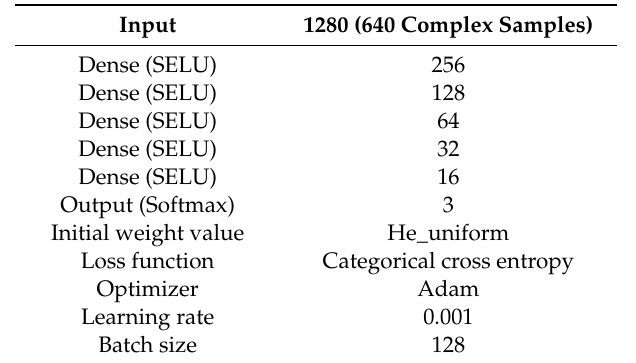
Table 1. Configuration of the proposed seven-layer deep learning network.